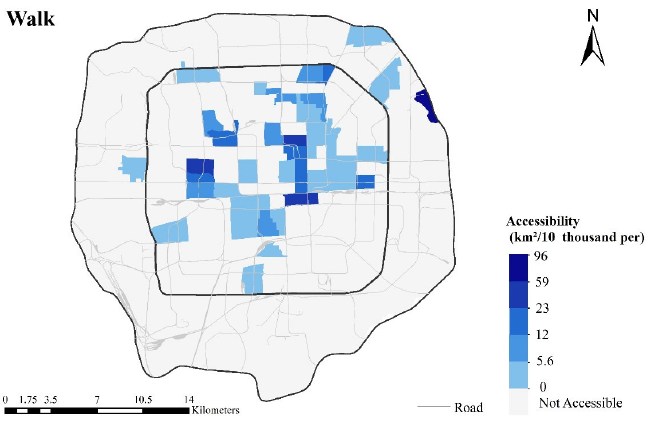
Figure 7. The accessibility results of walking.